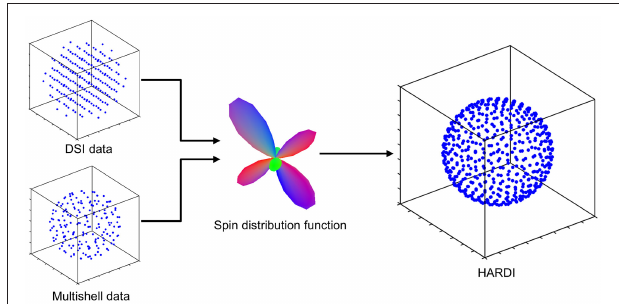
FIGURE 1 | The scheme conversion method uses the spin distribution function (SDF) to convert multi-shell or DSI data to their corresponding HARDI representation. This is made possible by the linear relationship between the diffusion signals and the SDF provided by the generalized q-sampling reconstruction